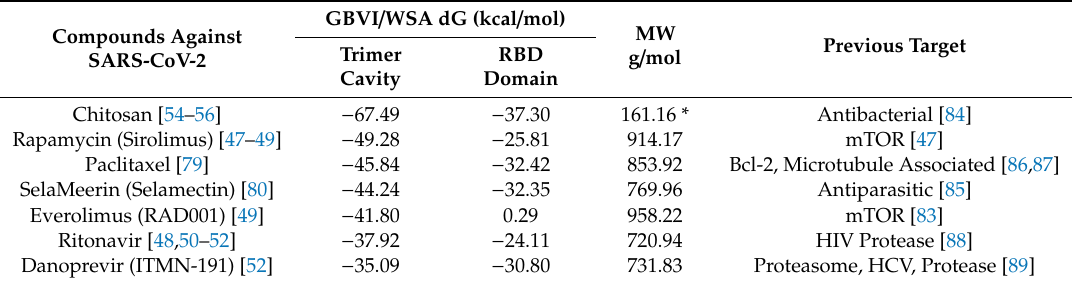
Table 1. The list of compounds showing the highest binding a ffi nity to the trimer cavity from the spike protein, and the compounds that are already validated or suggested to be / can be active against the SARS-CoV-2 virus